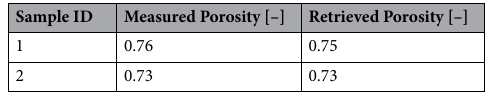
Table 2. Validation of the process—porosity.